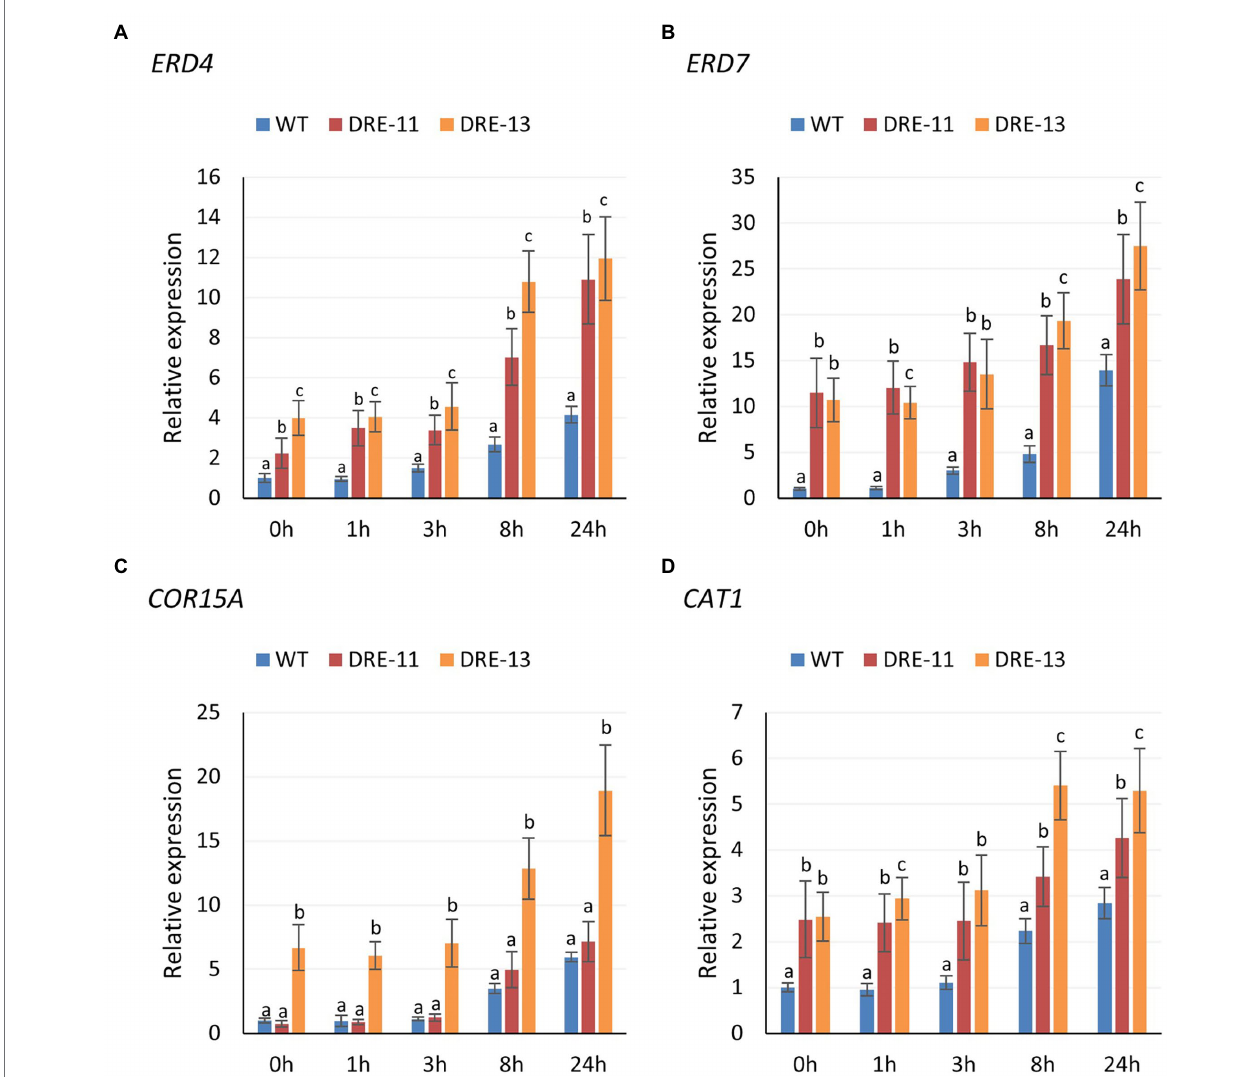
FIGURE 8 | Expression levels of CORs ( A , ERD4 ; B , ERD7 ; C , COR15A ) and (D) CAT1 of PaDREB1A transgenic lines and WT plants after different cold stress treatment times. Means with the same letters are non-significantly different for different transgenic lines and WT